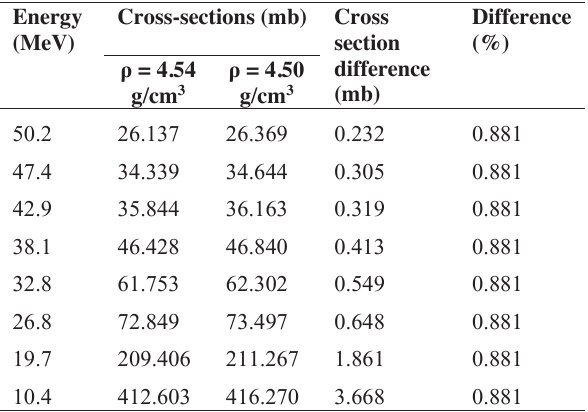
Table 3. Measured cross-sections for nat Ti(α,x) 51 Cr nuclear processes.